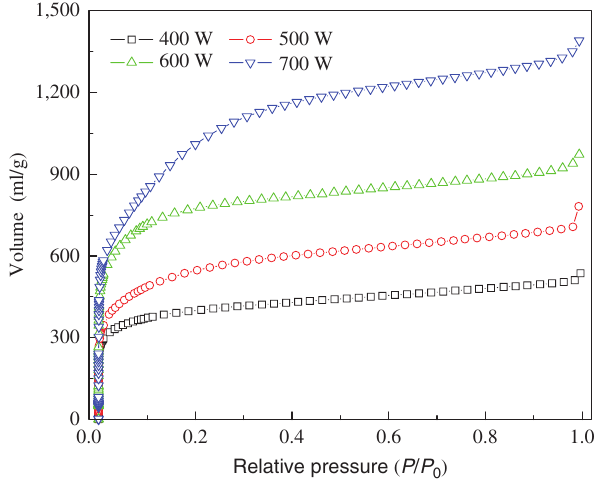
Figure 1: Nitrogen adsorption isotherm of the activated carbon with different microwave power.